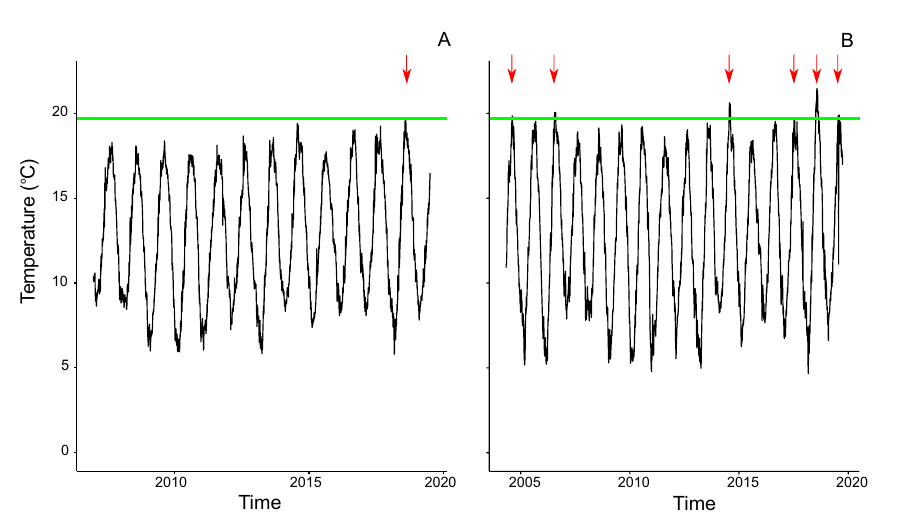
Figure 4. Daily average temperature ( ◦ C ) in Weymouth from 2006-01-01 to 2019-06-30 ( A ) and in Poole from 2004-05-01 to 2019-09-30 ( B ). The green horizontal line corresponds to the threshold temperature for spawning set at 19.7 ◦ C and the red arrows to favorable conditions for spawning